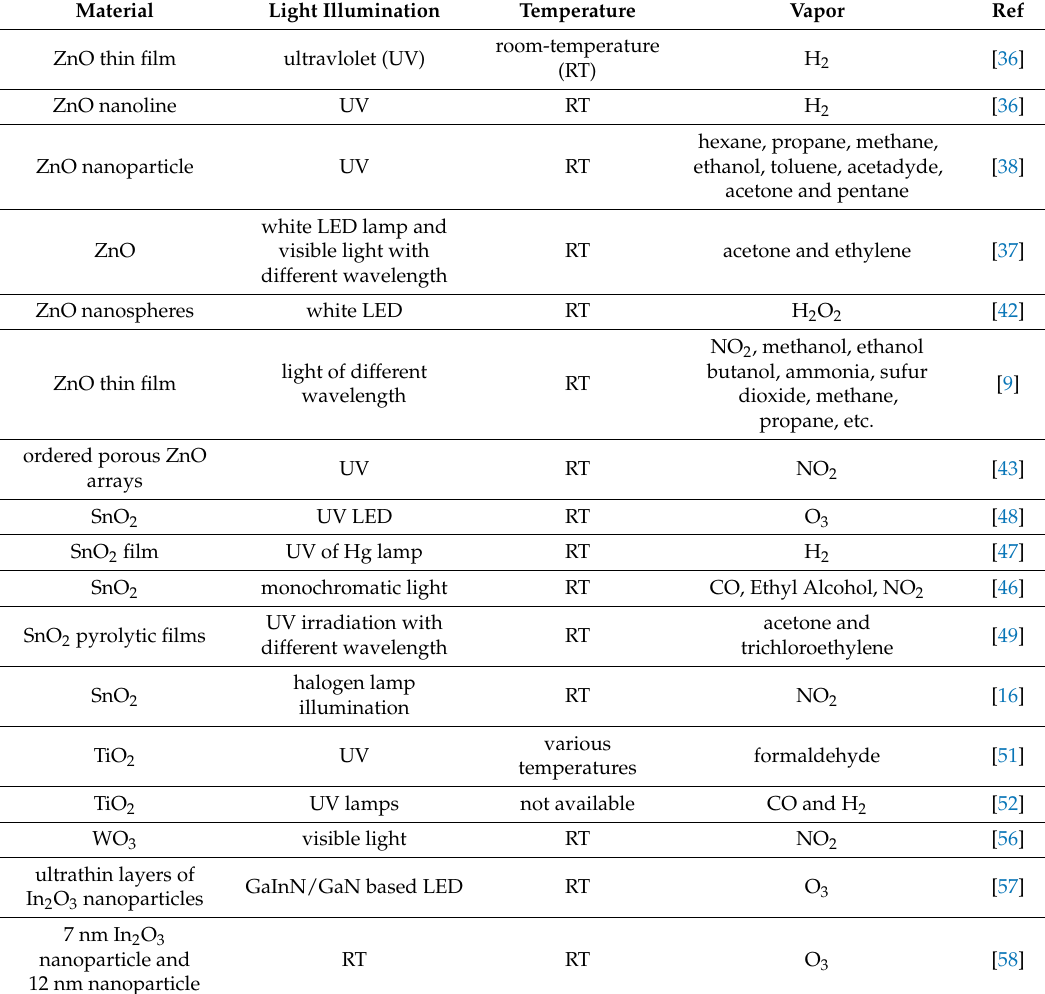
Table 3. PSummary of key reported work on light-activated gas sensor based on metal oxides